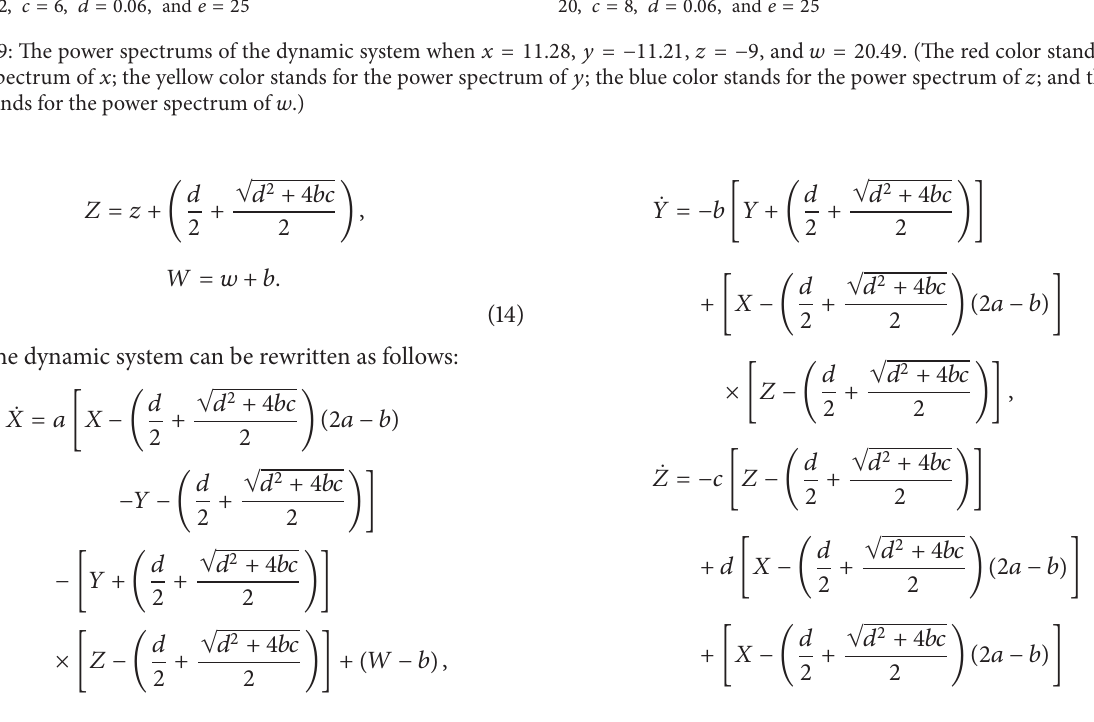
(a) The power spectrums of the dynamic system with 𝑎 = 0.98, 𝑏 = 12, 𝑐 = 6, 𝑑 = 0.06, and 𝑒 = 20